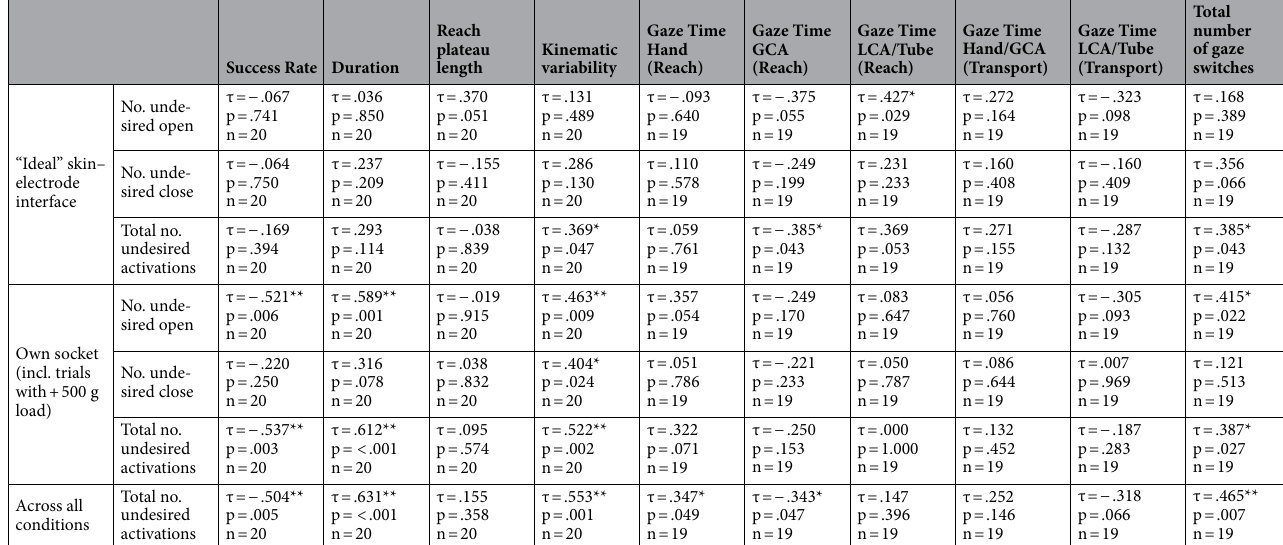
Table 1. Kendall’s tau-b correlation matrix (2-tailed), comparing the total number of undesired hand activations to the measures of functionality on the cylinder task. ** Correlation is significant at the .01 level. *Correlation is significant at the .05 level.